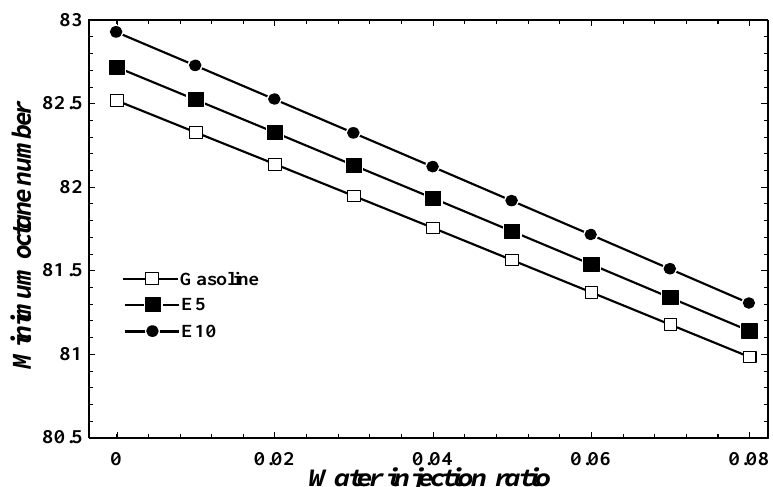
Figure 10. Minimum octane number in various water injection ratios for each fuel.